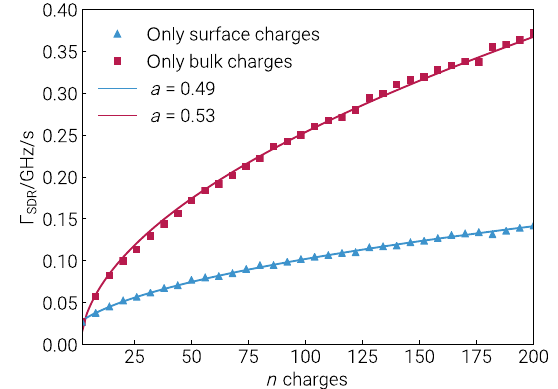
rate.FIG. 13. Spectral diffusion rate scaling behavior. Shown are the SDR for no bulk charges (red triangles) and no surface charges (green squares) as a function of the number of charges contrib- uting to the diffusion process. The parameters are the same as for Fig. 12. The solid lines correspond to a power-law fit with Γ b ð n − n 0 Þ a . The power laws show a surprising similarity SDR ¼ to the power laws in Fig.